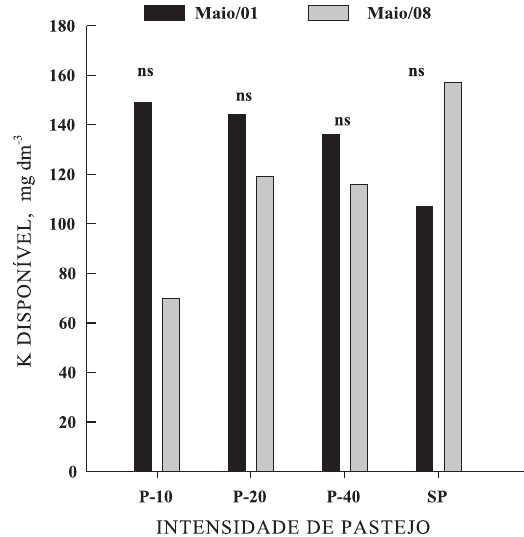
Figura 1. Teores de potássio disponível (Mehlich-1) na camada do solo de 0-20 cm em função de di- ferentes intensidades de pastejo (10, 20 e 40 cm de altura do pasto - P-10, P-20 e P-40, respectiva- mente) e sem pastejo (SP), em maio de 2001 e maio de 2008. ns: não significativo, dentro de cada tratamento, pelo teste F (p <